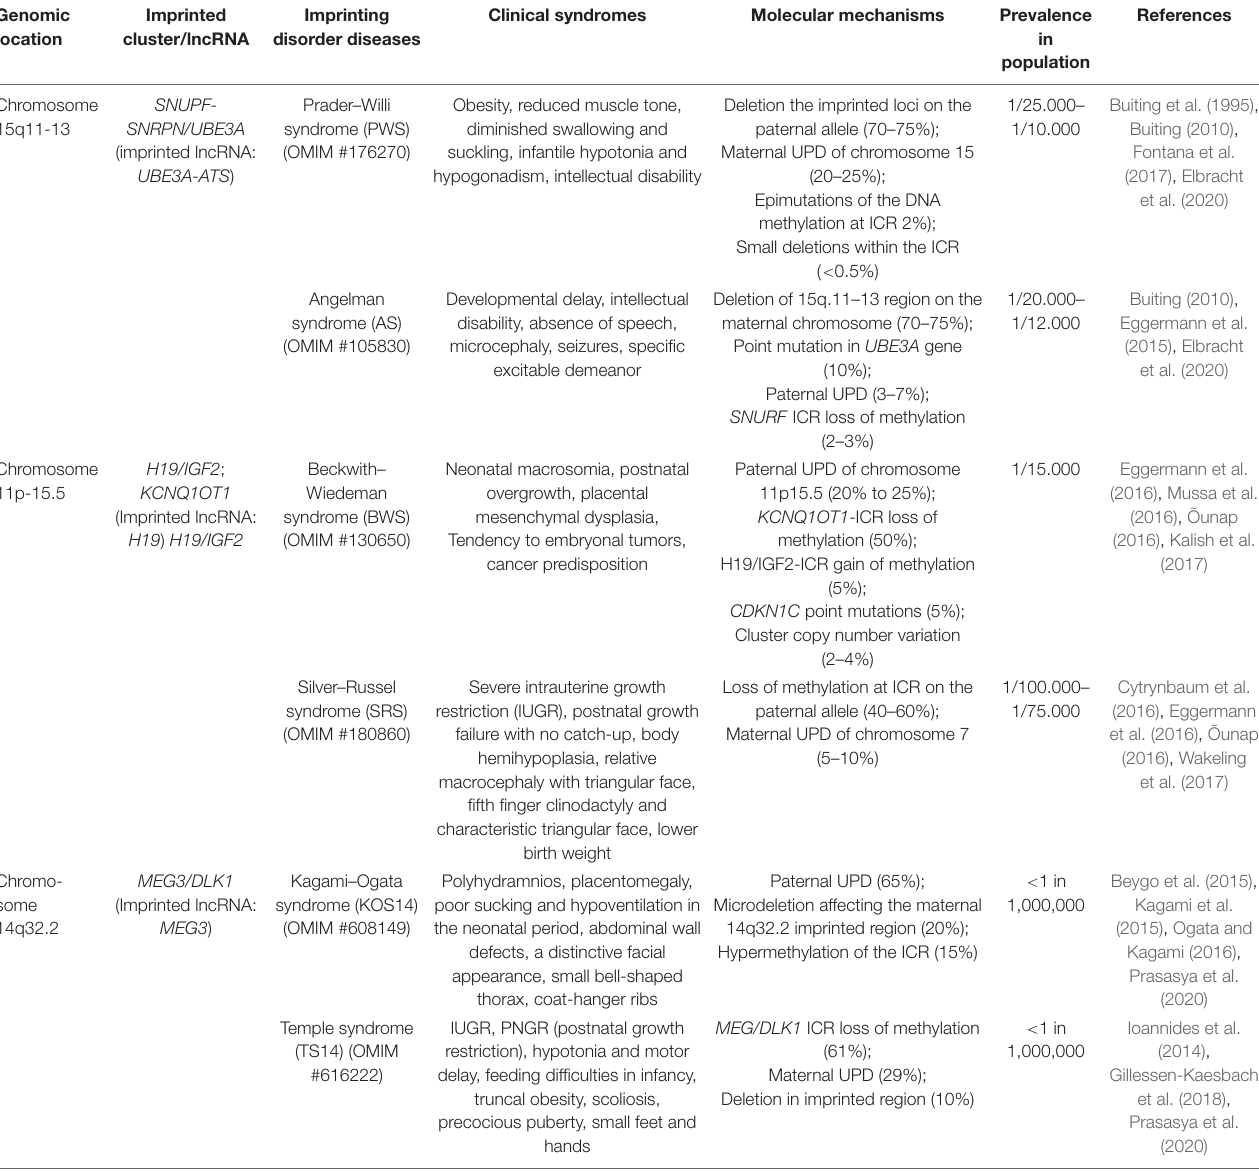
TABLE 1 | Human imprinting disorder-related